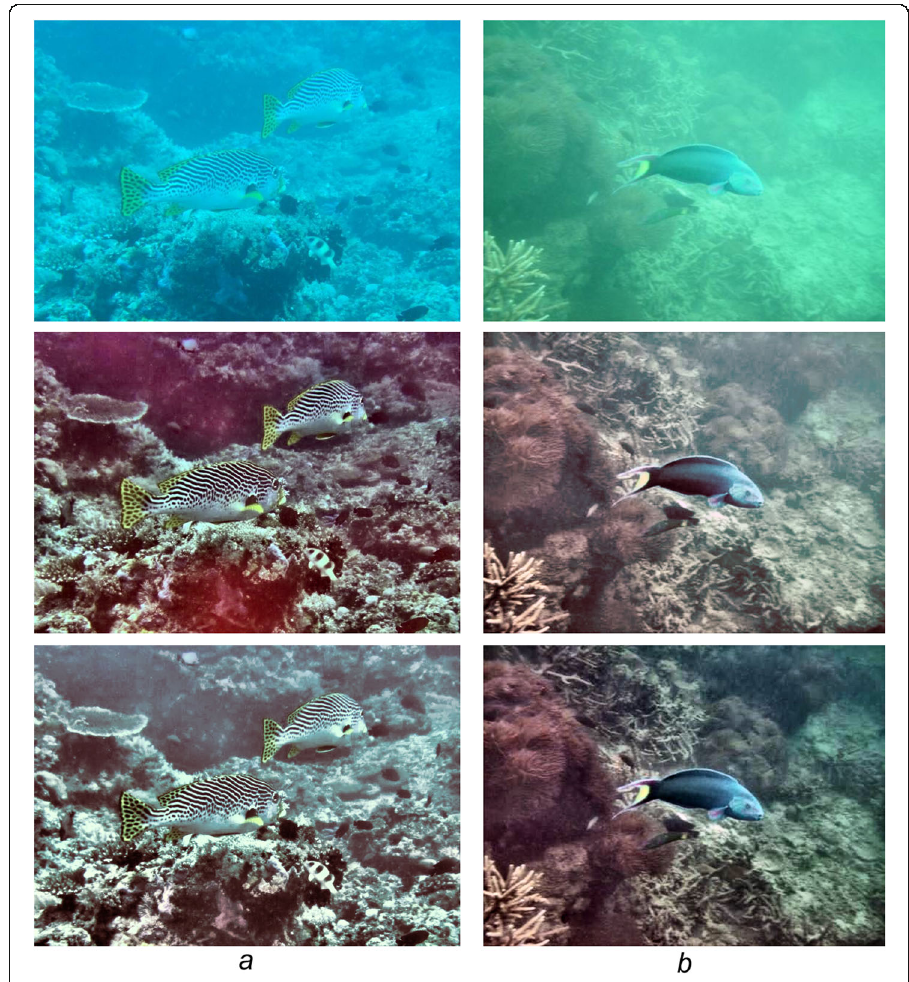
Fig. 12 Illustration of the influences of the red deficiency mechanism. Top row: input images, middle row: restoration results based on the route decided by the measure using Eq. (3), bottom row: restoration results using the other